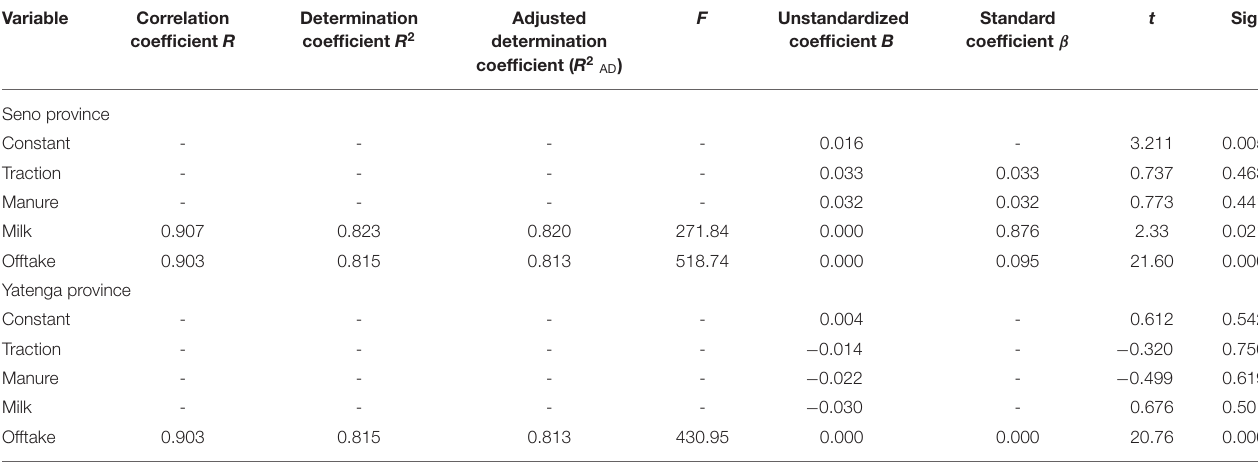
TABLE 6 | Stepwise regression of beneficial output variables of livestock water productivity in the Seno and Yatenga provinces.